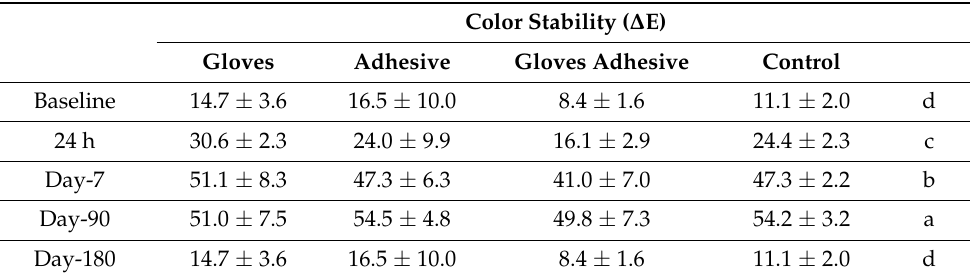
Table 4. Data resulting from color stability test ( ∆ E) for composite resin specimens handled/modeled under different techniques (gloved-hands and/or adhesive), in different evaluation times *.